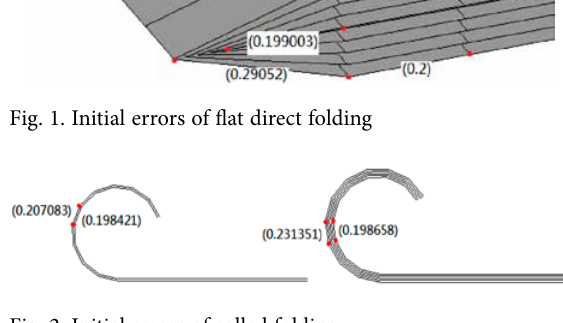
Fig. 2. Initial errors of rolled folding